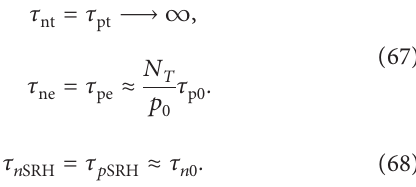
Figure 3: Room-temperature localized state energy dependence of (a) τ discussed in Figure